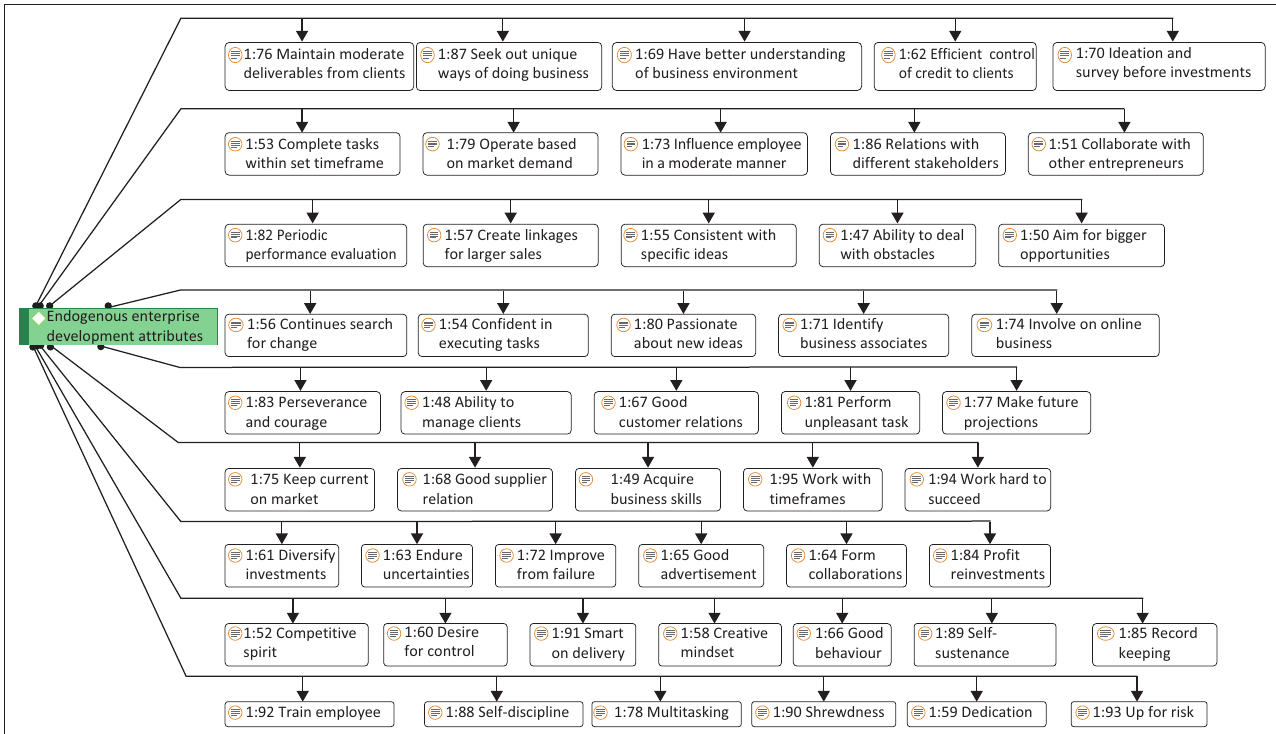
FIGURE 1: Network diagram showing endogenous variables influencing SME